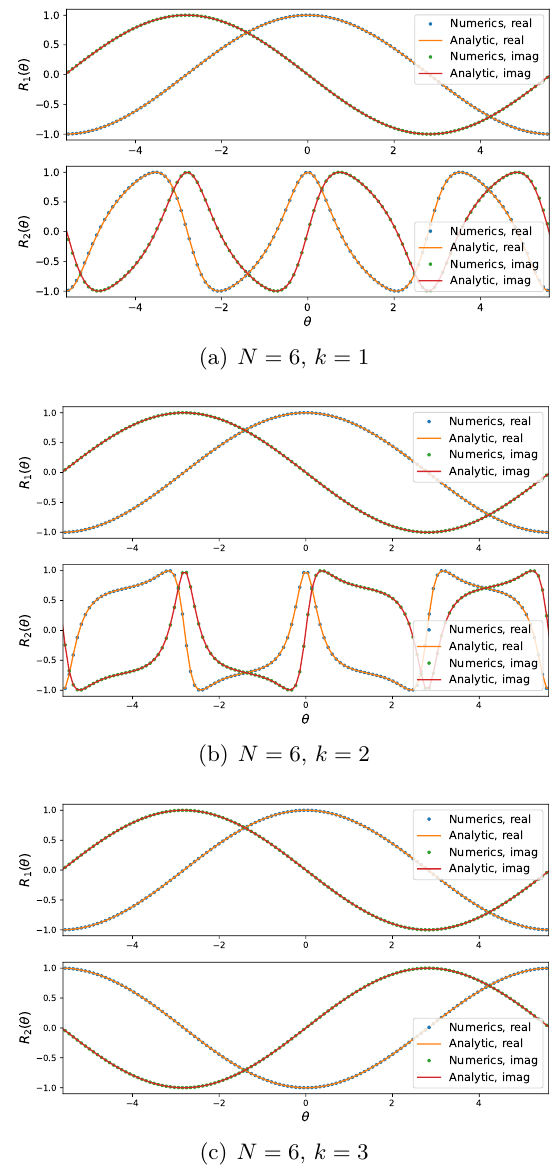
Figure 10 . Real and imaginary part of R 1 ( θ ) and R 2 ( θ ) on the real axis. There is perfect agreement between the R-matrix bootstrap and the analytic solutions. We take N = 6 , k = 1 , 2 , 3 , and θ = i π , − 0 . 329 i, 0 0 4